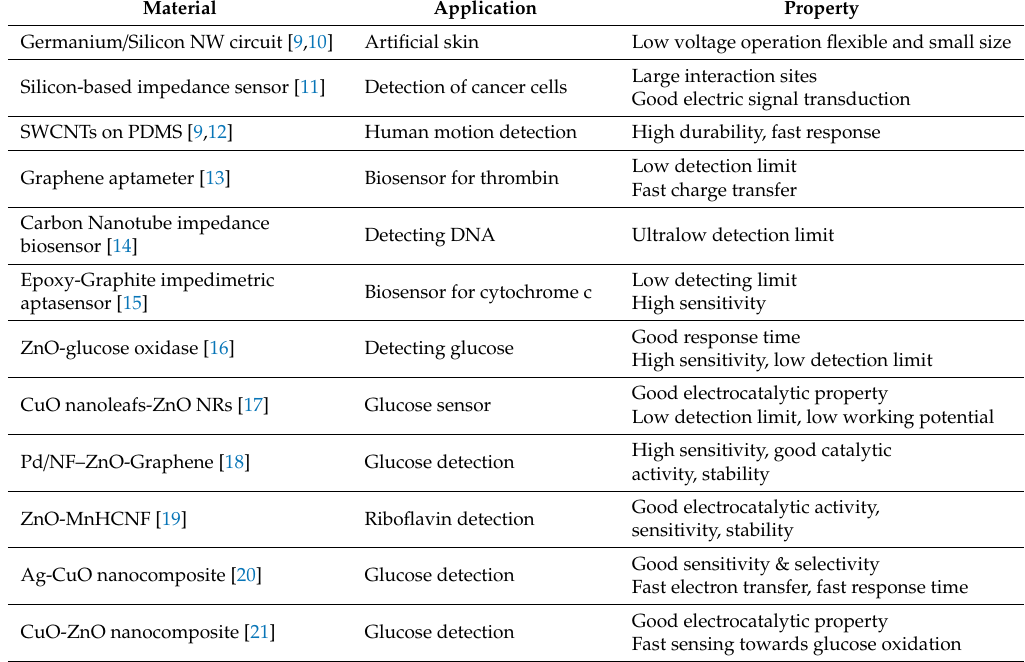
Table 1. Summary of di ff erent materials and composites used for biosensor